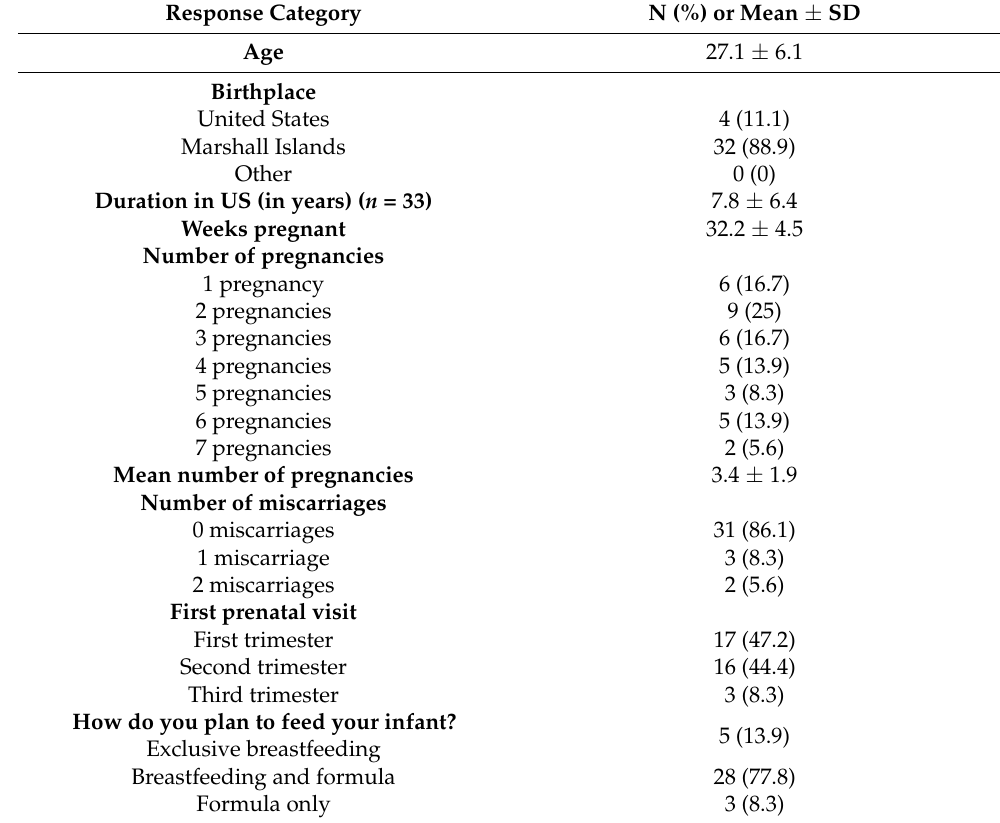
Table 1. Demographics ( n =